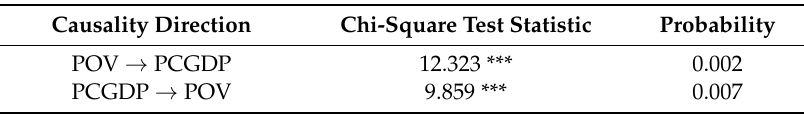
Table 5. Granger Causality